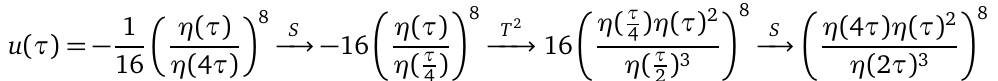
Figure 5: Fundamental domains for 4d SU ( 2 ) theories with N